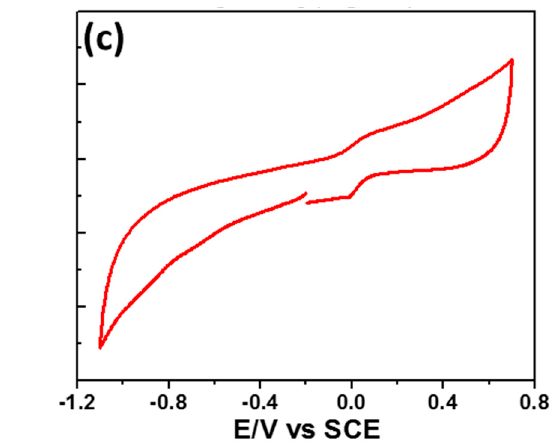
Figure 9. ( a ) Radical scavenging activity of GQDs, ( b ) reducing capacity of GQDs, and ( c ) cyclic